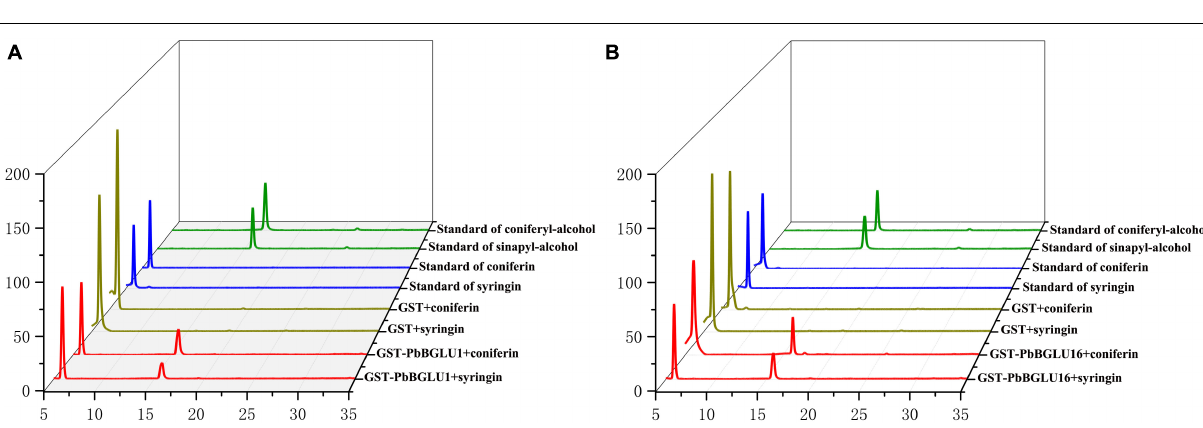
FIGURE 6 | Enzyme activity of GST-PbBGLU1 and GST-PbBGLU16 recombinant protein toward coniferin and syringin. (A) HPLC analysis of standards and reaction products of GST-PbBGLU1 recombinant protein. (B) HPLC analysis of standards and reaction products of GST-PbBGLU16 recombinant protein. Reaction conditions: 10 µ g of purified protein was incubated at 35 ◦ C with 20 µ L buffer (50 mM MgSO4, 200 mM KCL, 100 mM PBS pH 7.2–7.4) and 1 mM substrates (coniferin and syringin), the water was added to a final volume of 50 µ L. After 1 h of reaction, add 50 µ L methanol termination